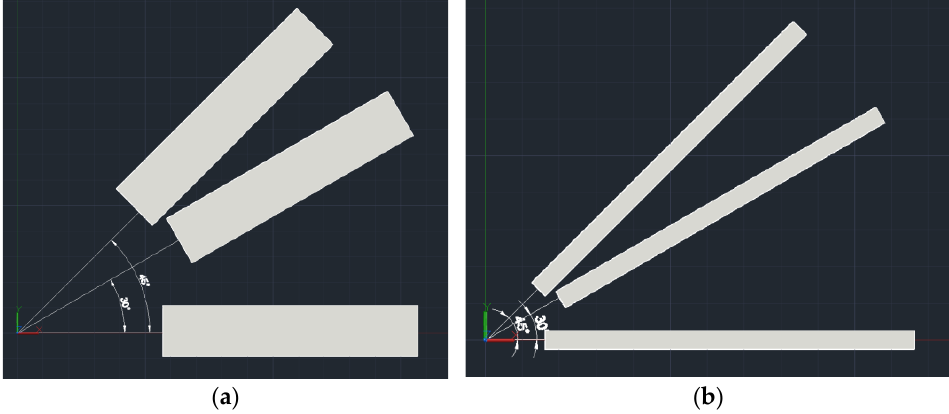
Figure 17. Placement of sample model 1. ( a ) Horizontal placement. ( b ) Sideways placement.